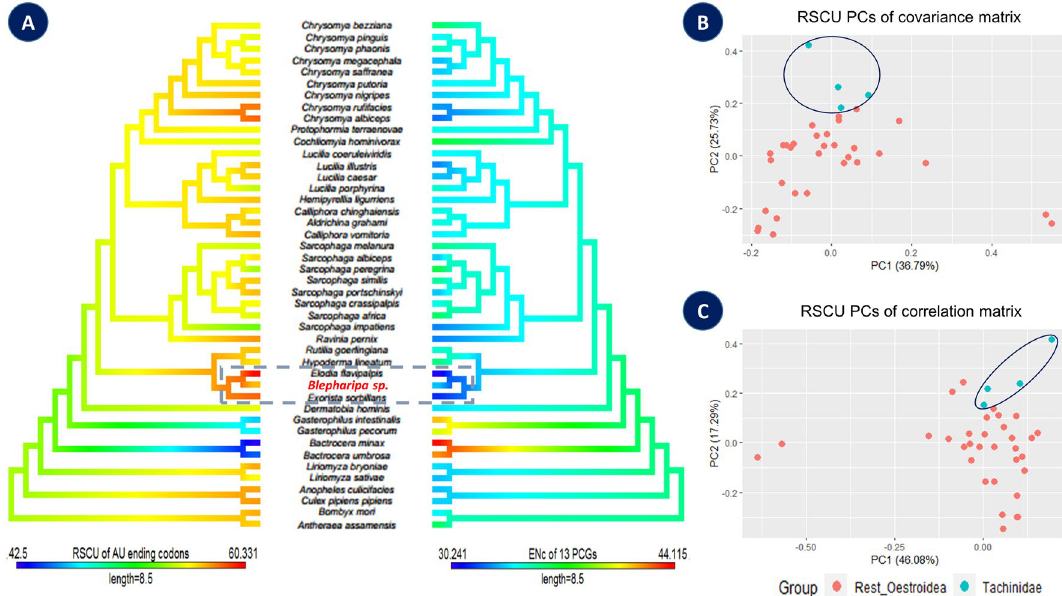
Figure 11. ( A ) RSCU value of AU ending codons and ENc of 13 concatenated PCGs. Contour map phylogeny shows the estimated evolutionary history of codon usage, and corresponding variation of ENc produced via contMap function in the R package Phytools. Note that the Tachinidae clade has evolved a AT content that is higher than the rest of the ingroup that is reflected in ENc. ( B ) and ( C ) Principal components analysis of RSCU across the Oestroidea. The Tachinidae groups are distinguishable from rest of the Oestroidea